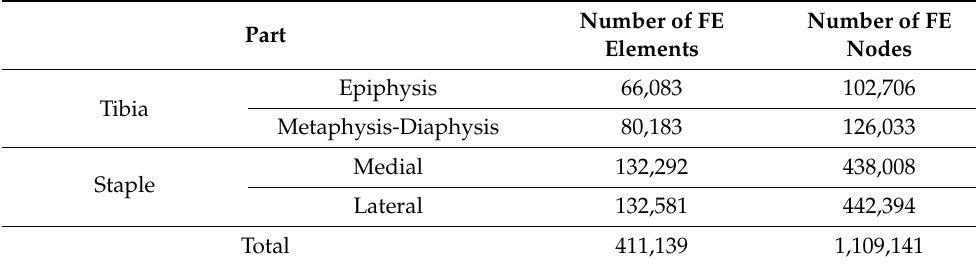
Figure 9. Refined FE mesh: ( a ) Detail of the mesh in/around the hole for the staple; ( b ) Mesh of the staple; ( c ) Element size on staple (mm). Table 2. Number of FE elements and